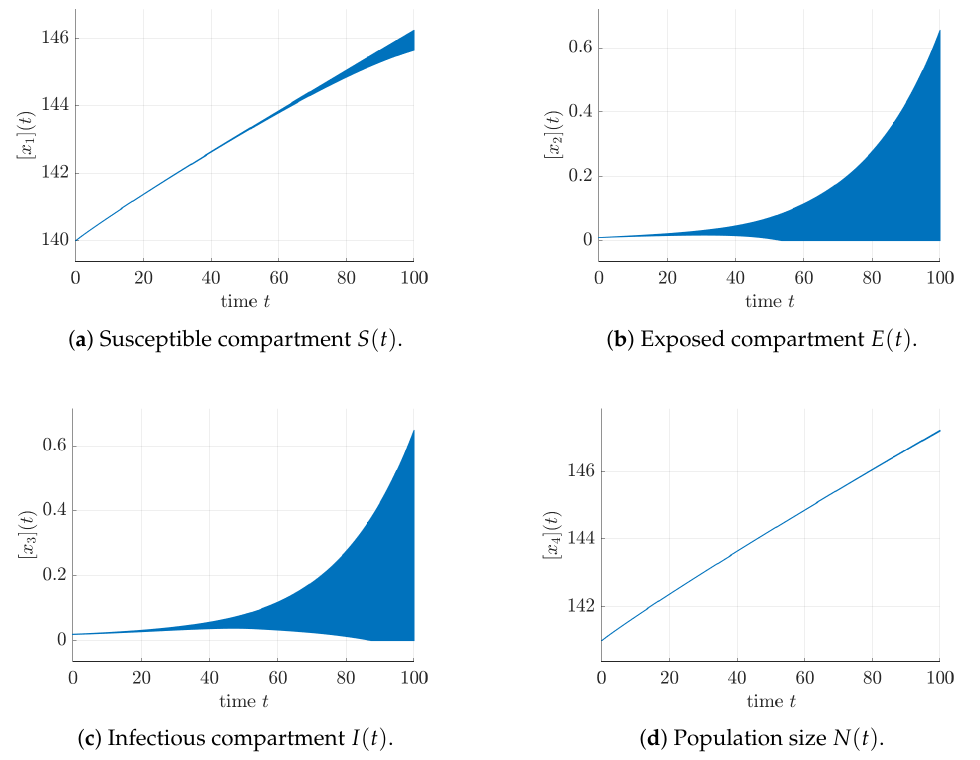
Figure 8. State enclosures for the SEIR model in Scenario 2 with the initial conditions